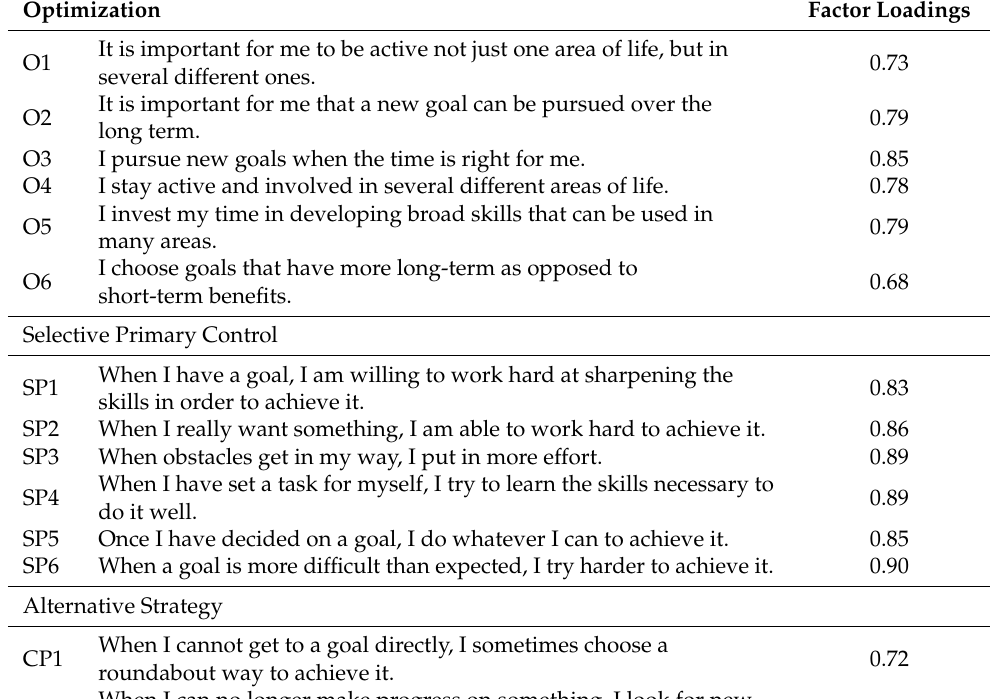
Table 2. Standardized factor loadings of Optimization in Primary and Secondary Control Scale.